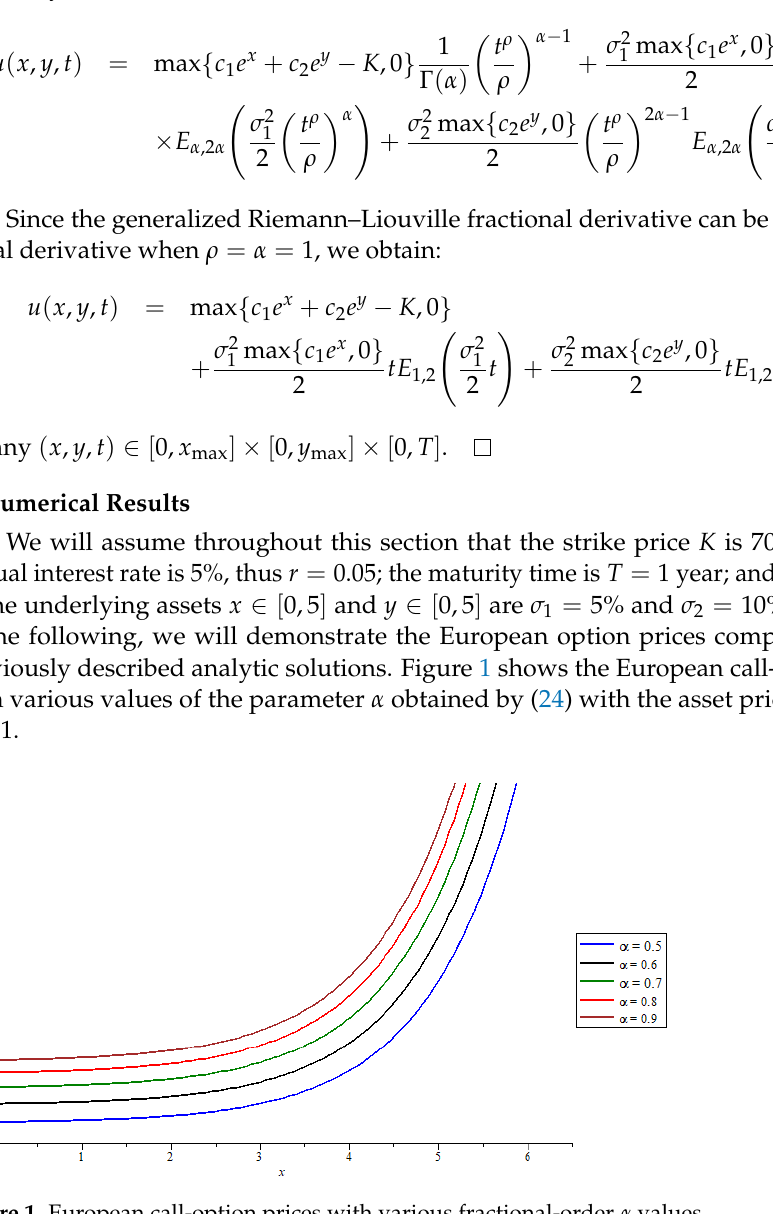
Figure 1. European call-option prices with various fractional-order α